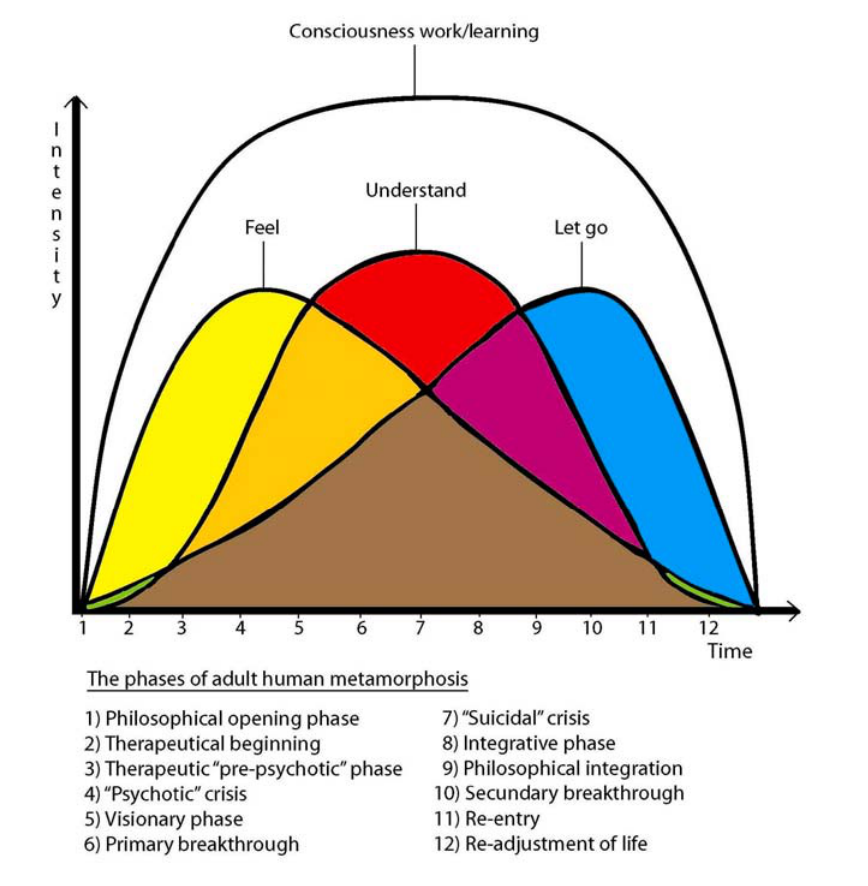
Figure 2: The experimentally found major phases and crisis in intensive dynamic short time therapy when complemented with bodywork [from